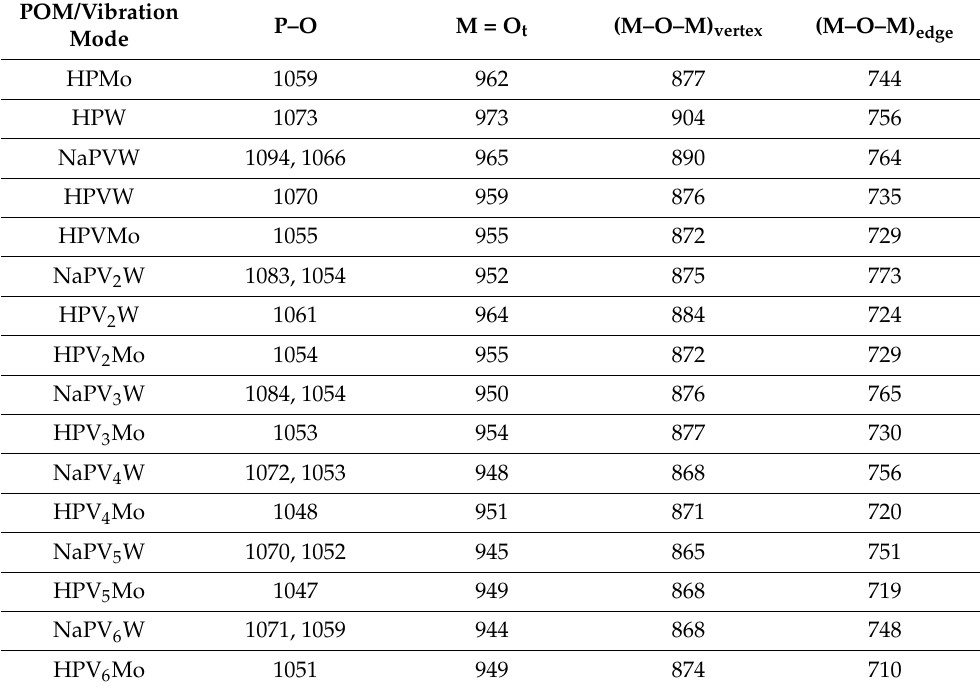
Table 2. Positions of the characteristic vibration bands of all POMs investigated in this